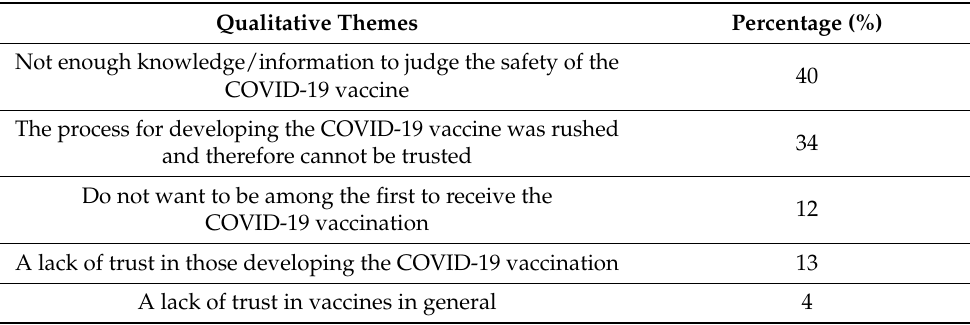
Table 2. Qualitative themes and percentages of appearance in coded